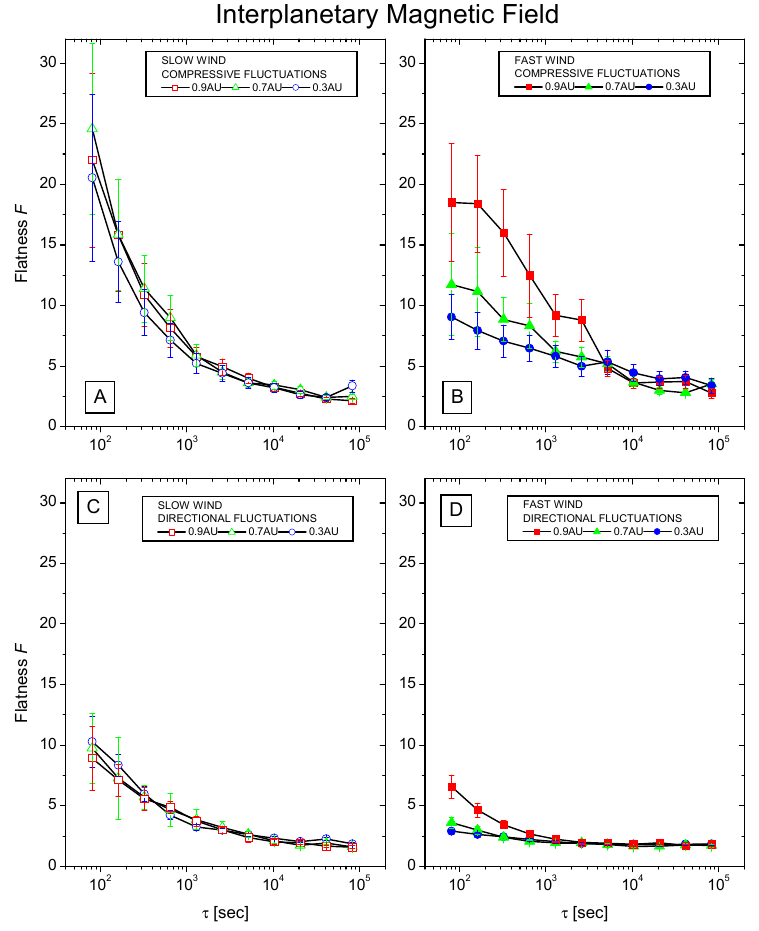
Figure 106: Flatness ℱ vs. time scale 𝜏 relative to magnetic field fluctuations. The left column (panels A and C) refers to slow wind and the right column (panels B and D) refers to fast wind. The upper panels refer to compressive fluctuations and the lower panels refer to directional fluctuations. Vertical bars represent errors associated with each value of ℱ . The three different symbols in each panel refer to different heliocentric distances as reported in the legend. Image reproduced by permission from Bruno et al. (2003b), copyright by